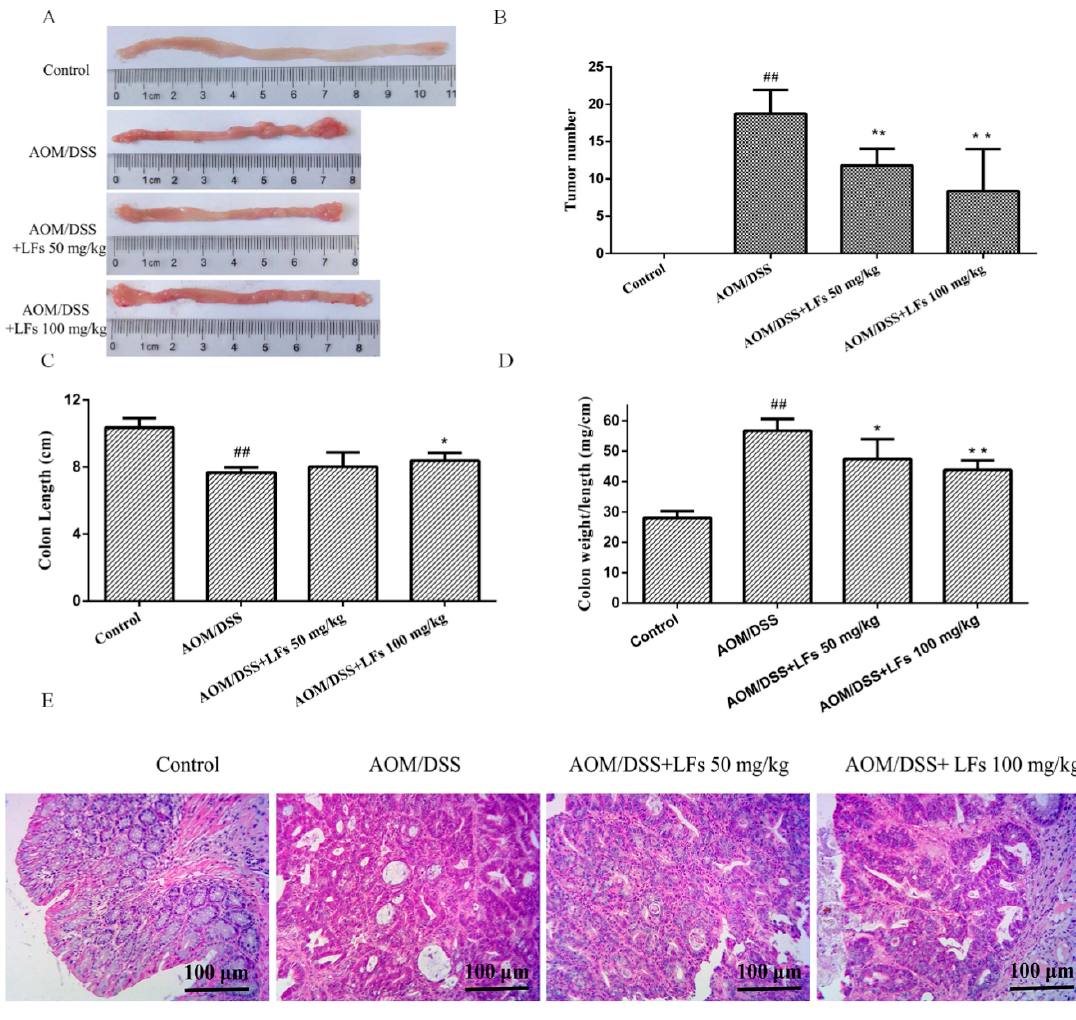
Figure 2. Effects of LFs on the burden of colonic neoplasms. ( A ) Microscopic view of colon in mice. AOM/DSS treatment resulted in 100% incidence of colonic neoplasms and no neoplasm was